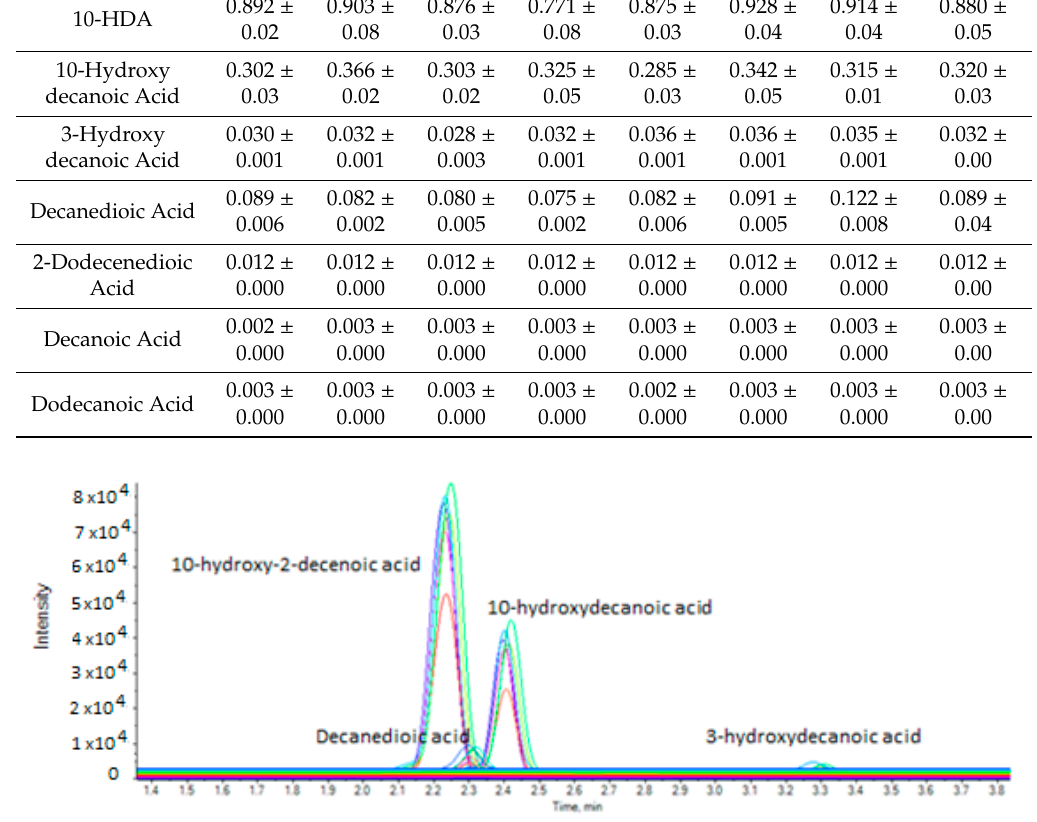
Figure 3. Multi sample analysis (seven RJ samples).